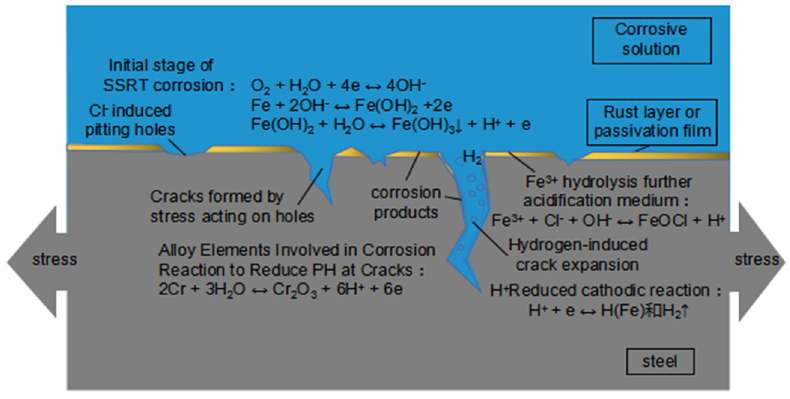
Figure 12: Demonstration diagram of SCC process of high manganese